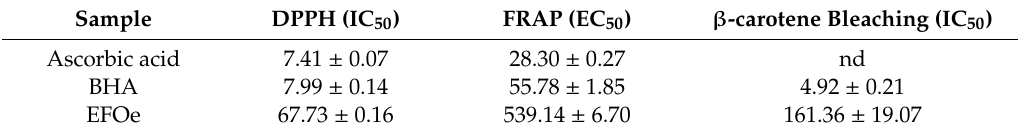
Table 5. Antioxidant properties of the extract of the endophytic fungus O. elatum (EFOe). Sample